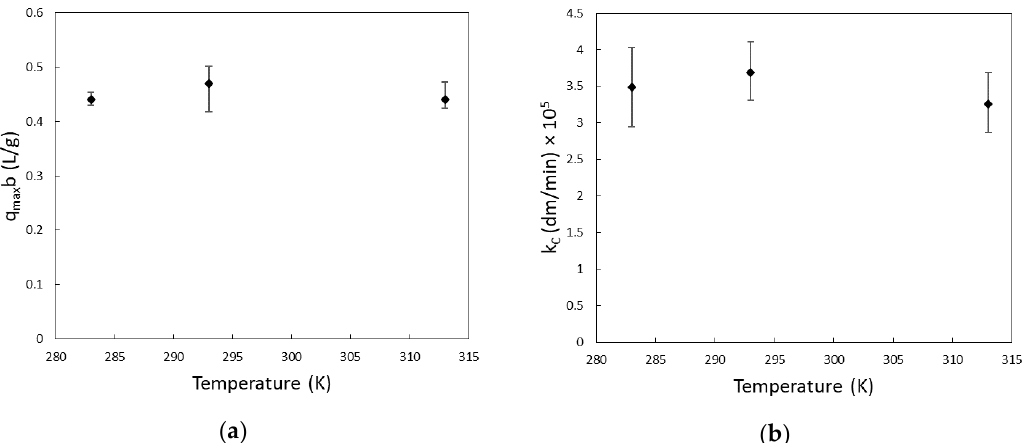
Figure 7. Variation of the parameters of fitting q max b ( a ) and k C ( b ) with temperature. The points reported are the means of the fitting values. Moreover, the error bars represent the maximum and minimum difference between the values of fitting and the mean.